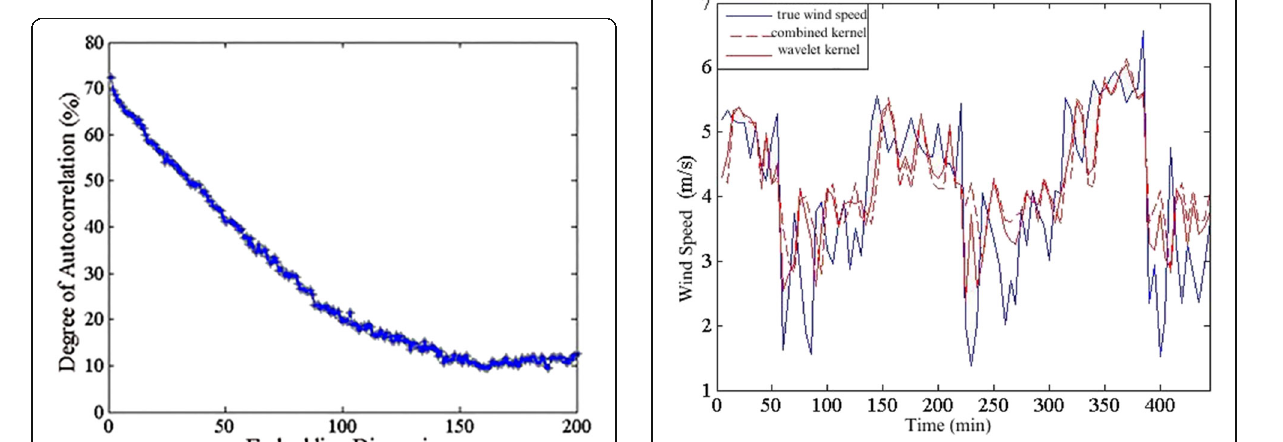
Fig. 3 The forecasting results with the combined kernel and wavelet kernel